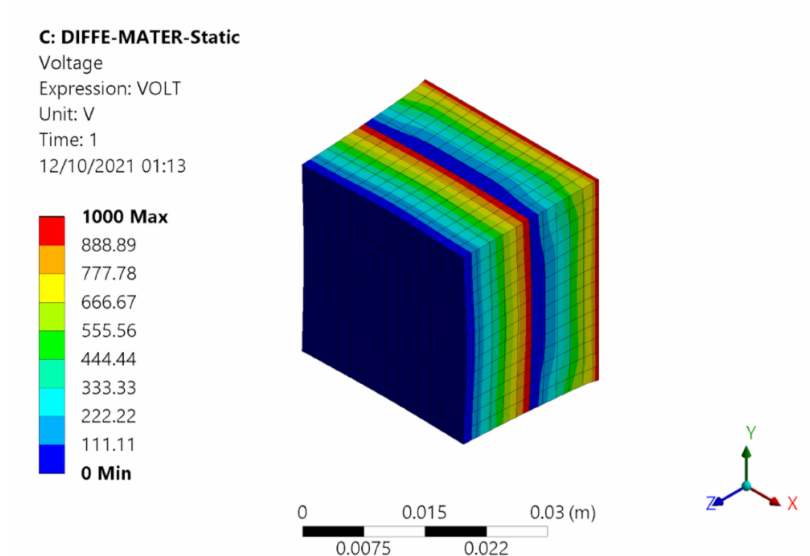
Figure 8. Voltage distribution across plates.